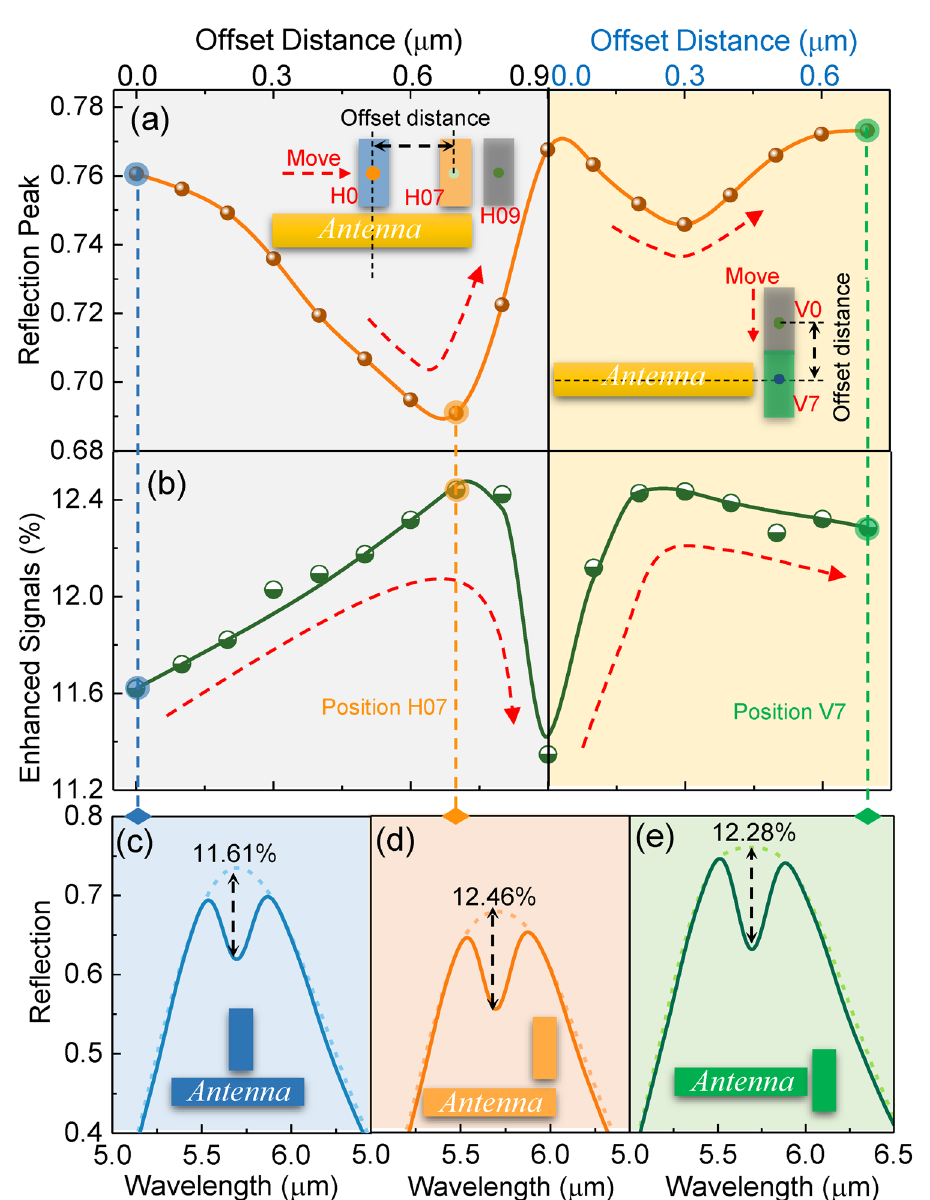
Fig. 2 Position optimization of nanogap in bright–dark mode coupling. a Simulated spectral reflection peak and b enhanced signal profile as the nanogap shifts from the horizontal center H0 to the vertical center V07, where “H” and “V” represent a horizontal or vertical movement, respec- tively, and the value is the distance moved. Left panel: the nanogap shifts horizontally from H0 to H09; right panel: the nanogap shifts vertically from V0 to V07. The simulated reflection spectra when the dark mode rod is located at c the vertical center of the antenna, d the right end of the antenna, e and the vertical center of the antenna. Dotted line: the baselines of